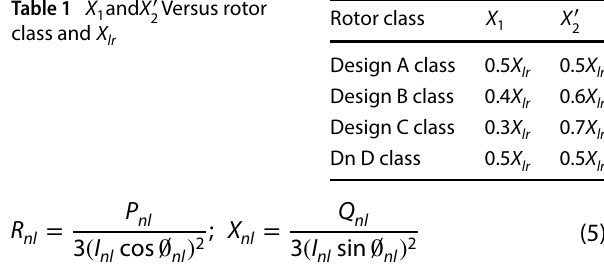
Table 1 X 1 and X ′